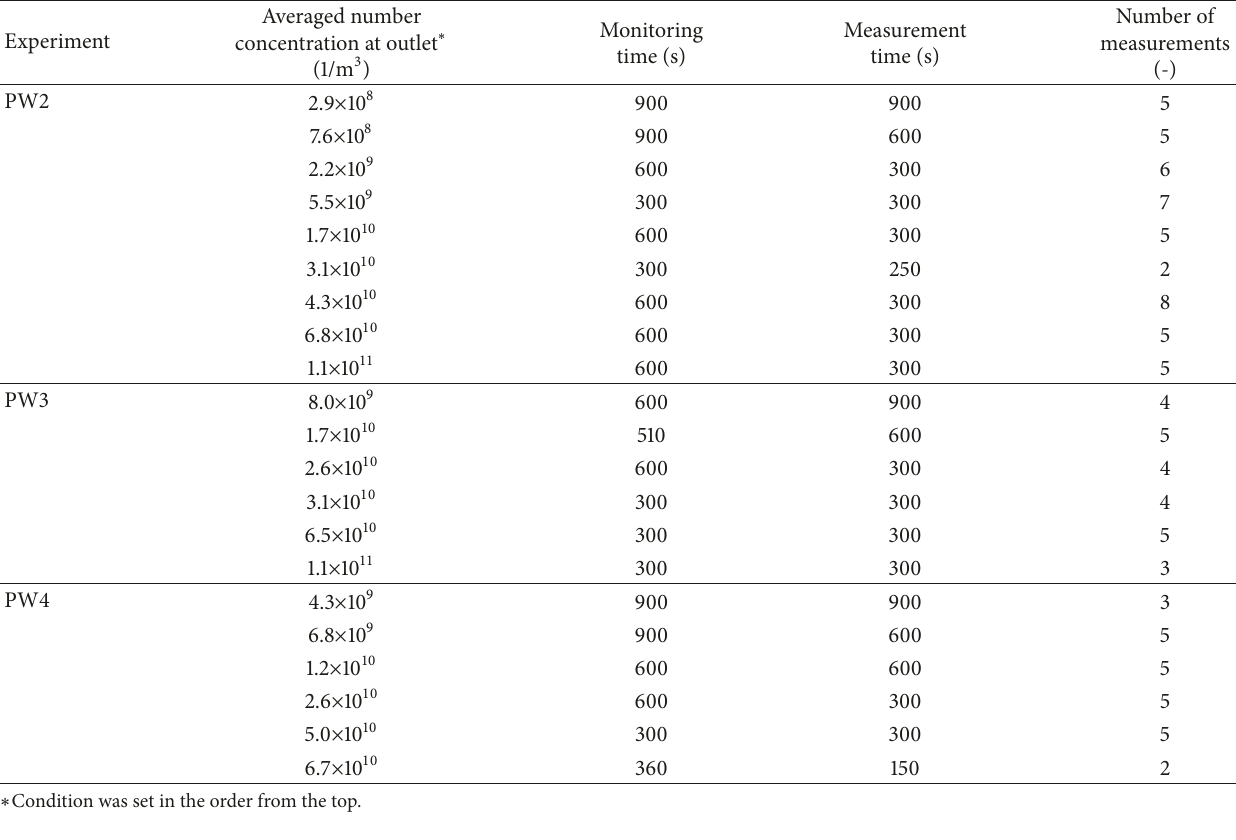
Table 5: Aerosol measurement information of the experiments PW2-PW4.